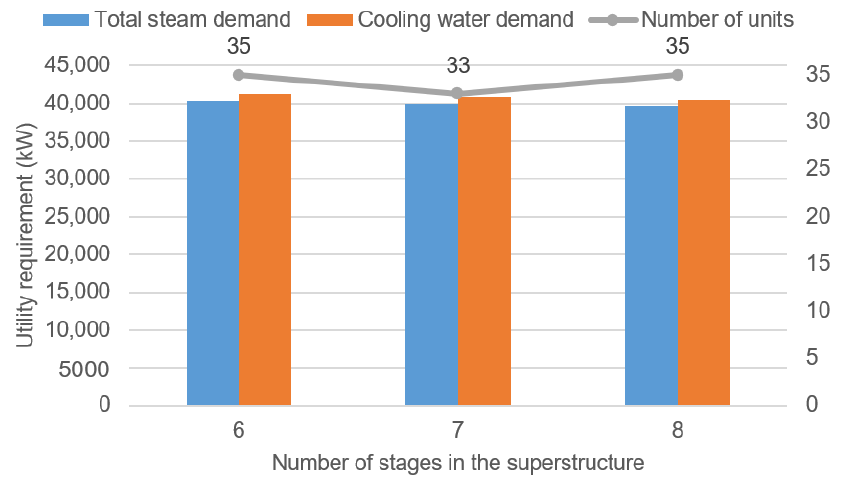
Figure 2. Minimum utility requirements versus the number of stages.